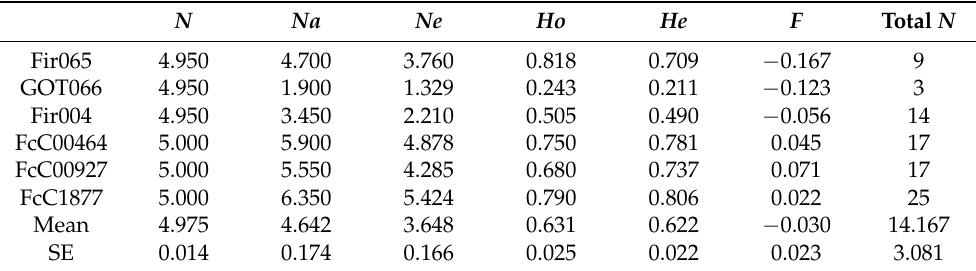
Table 5. Average genetic diversity indices over all plots for each nSSR marker. N